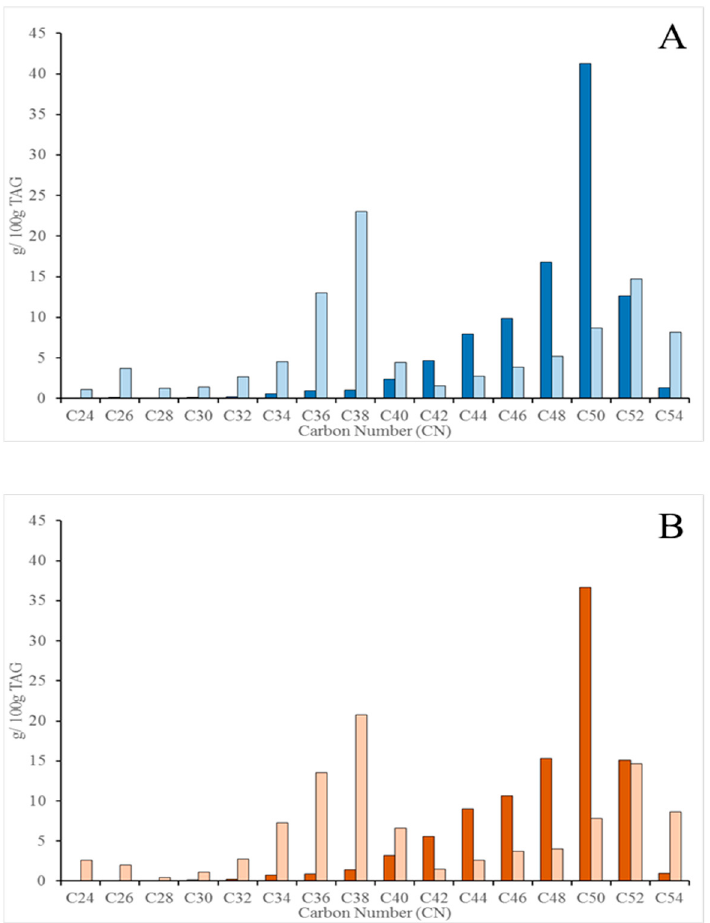
Figure 3. Distribution of the acylglycerols molecular species (%) in HM samples, according to their CN. ( A ) raw HM samples (undigested ■ and digested ■ ). ( B ) pasteurized HM samples (undigested ■ and digested ■ ). Significant differences were observed when each pair of CN value was compared except for the CN40 and CN52.